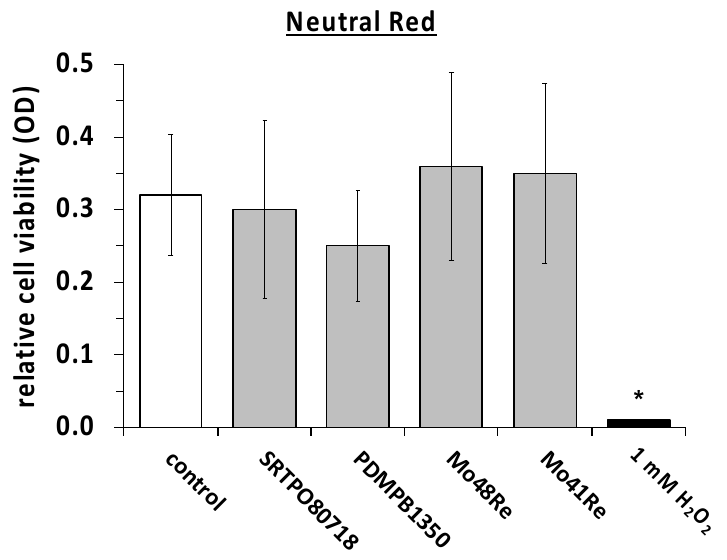
Figure 4. Neutral red assay with L929 mouse fibroblasts. *, p < 0.05 as compared to the control (paired two-tailed Student’s t -test).